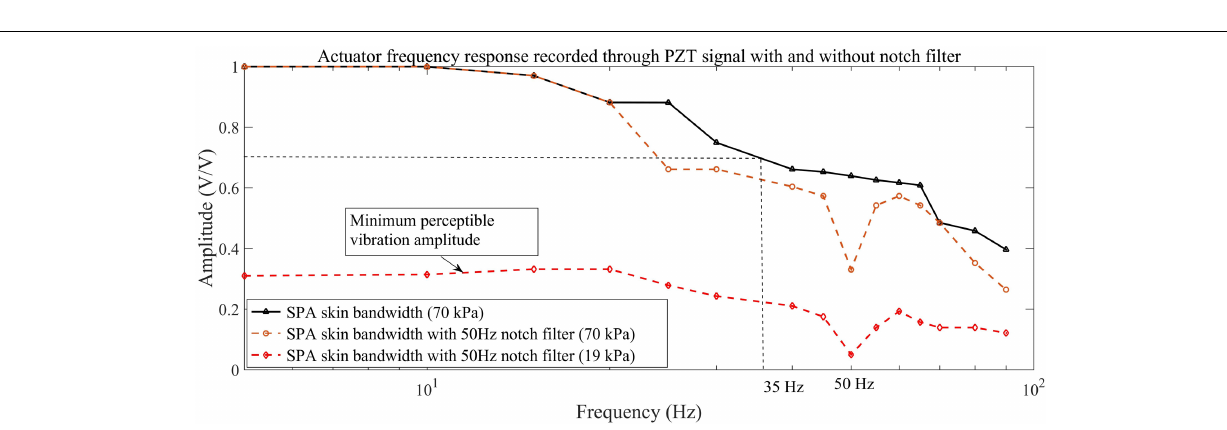
FIGURE 7 | Frequency response of sensor integrated SPA skin as measured by the control environment . The SPA skin produces measurable vibrations from 19kPa onward of the regulator pressure. The SPA skin amplitude response at 70kPa is always above the minimum perceptible amplitude for the frequency range of